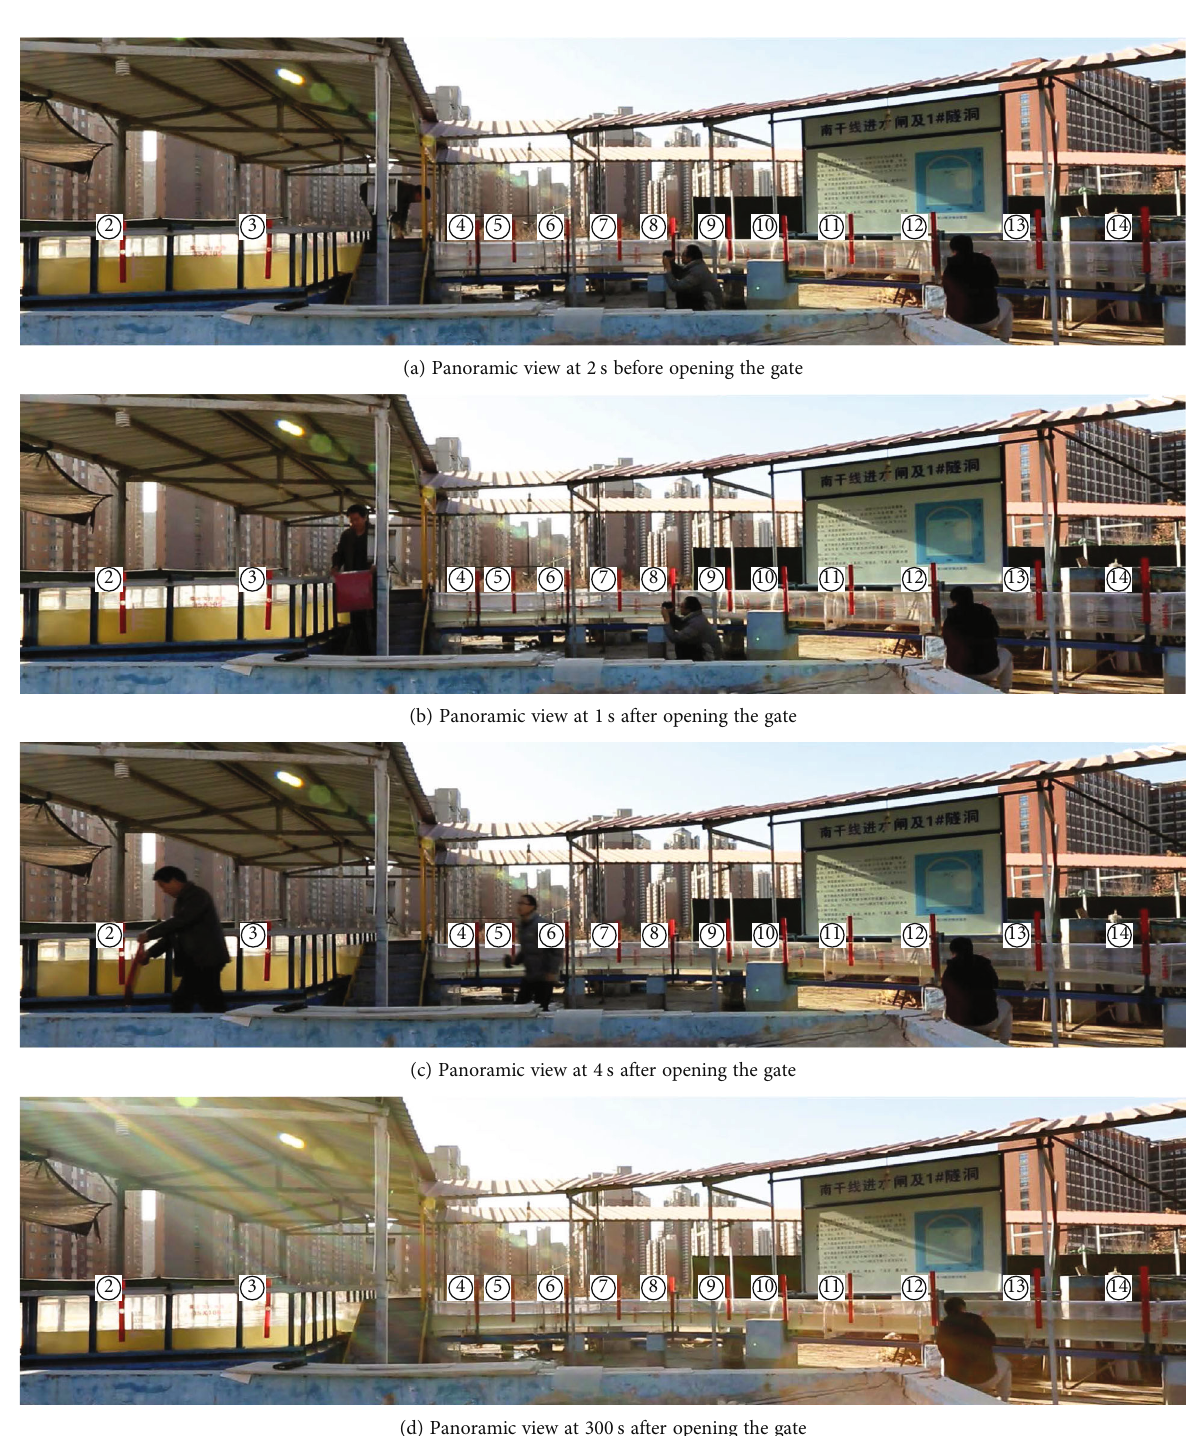
Figure 5: Instantaneous water surface images in the Water Distribution Pool and the Southern Main Tunnel under operating condition